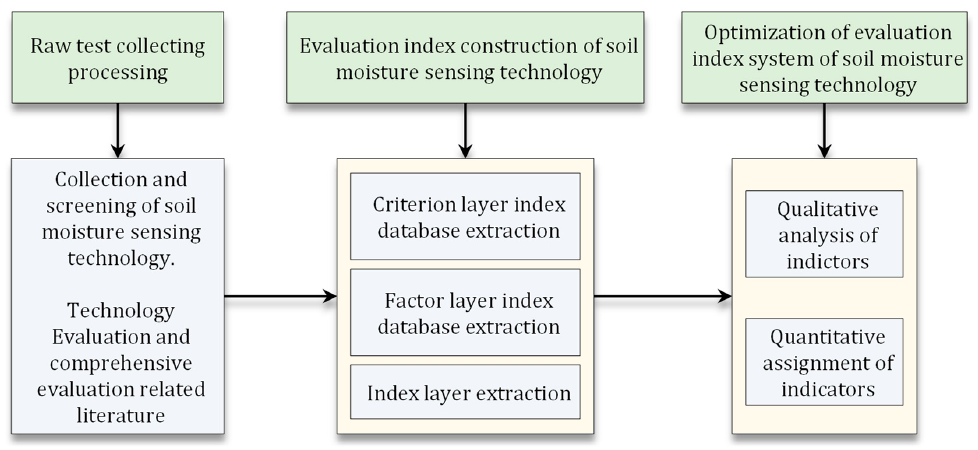
Figure 2. Construction process of the evaluation index system.